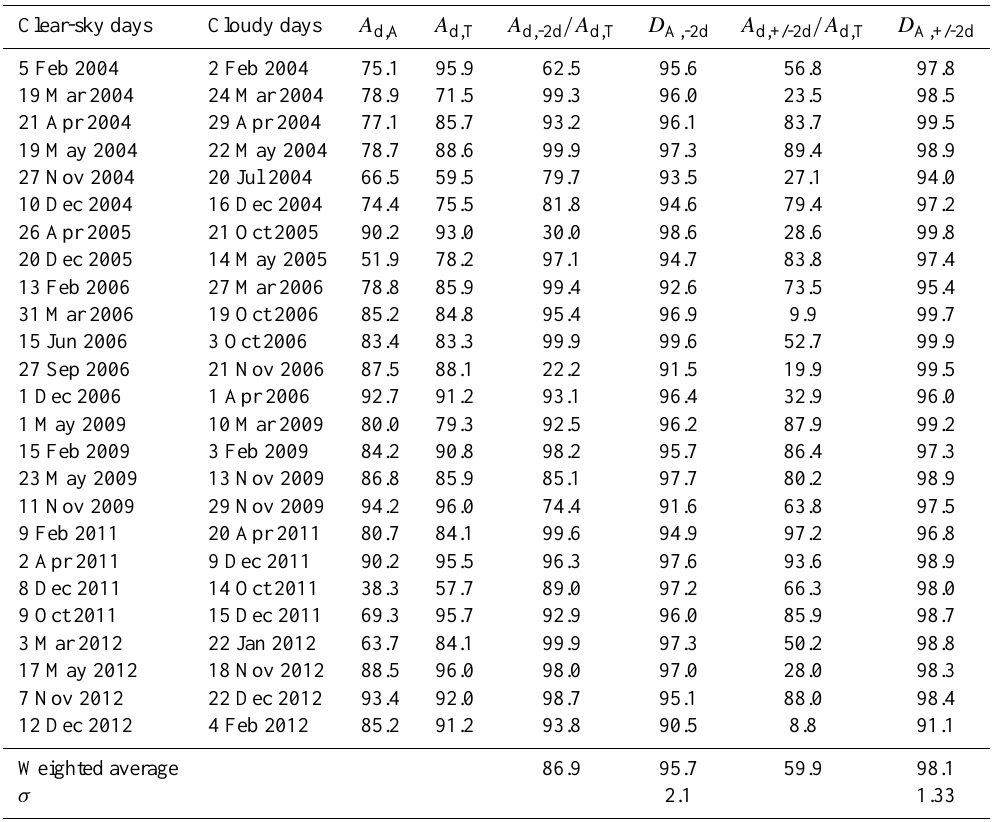
Table 10. Efficiency and accuracy of the conservative filter of step 2 (subscript ± 2d) compared to a basic 2 day backward temporal filter (subscript − 2d). Both filters are applied to maps preprocessed by step 1. Values in [%]. Clear-sky days